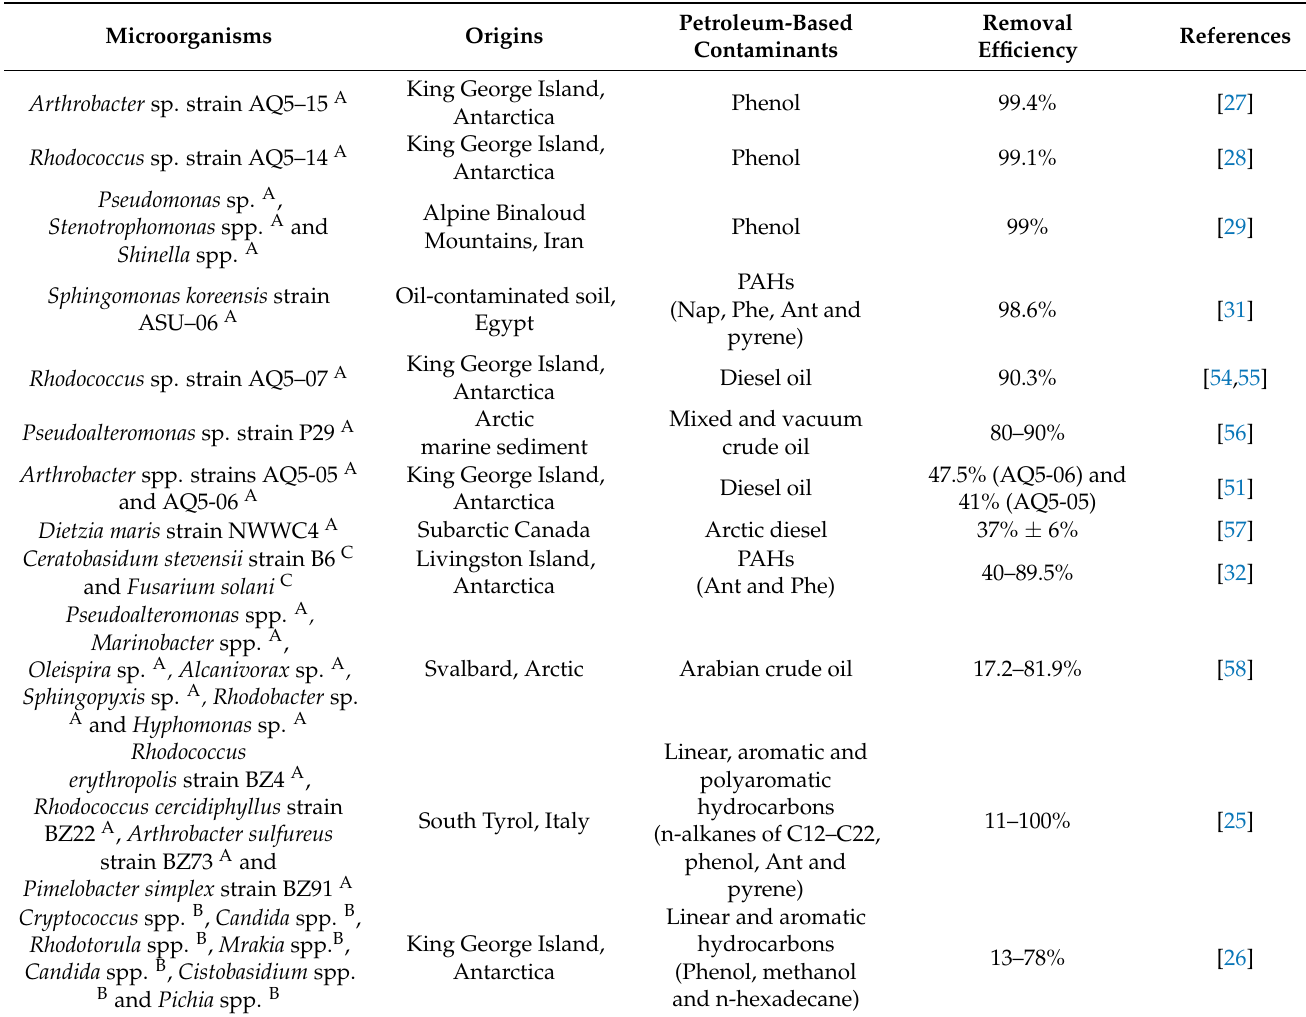
Table 2. Potential cold-adapted, hydrocarbon-degrading microorganisms in hydrocarbon bioremediation treatments.